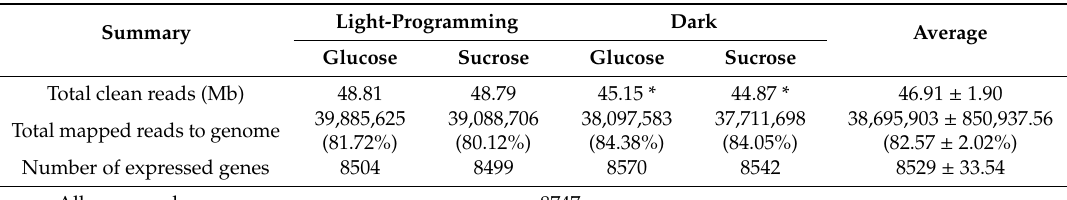
Table 2. Mapping results of C. militaris TBRC6039 transcriptome.